Question: Briefly state, in one sentence, what is plotted here.
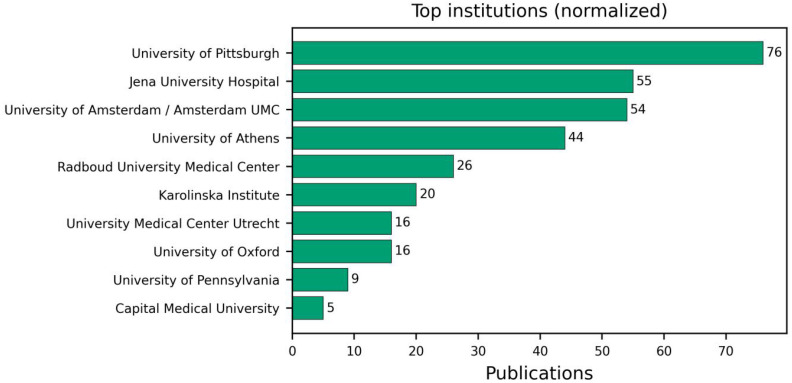
Answer: Top institutions by publication output in host response-oriented sepsis research. Institutional productivity was calculated from standardized affiliation information in the final dataset. The image ranks the leading institutions according to publication output, reflecting major organizational contributors to research on sepsis host response, immune heterogeneity, biomarkers, and precision stratification.